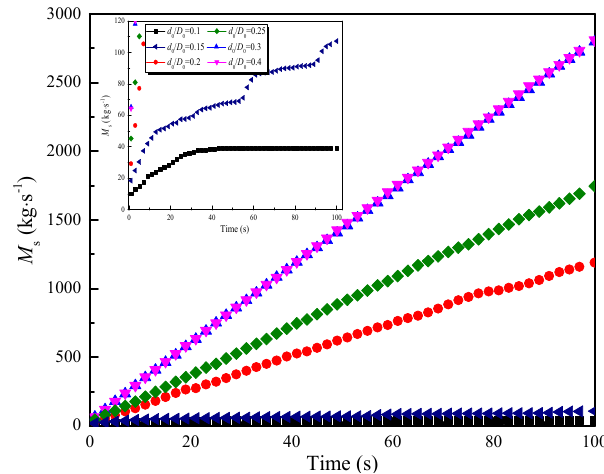
Figure 14. The variation in cumulative mass discharge with operating interval time for different normalized outlet scales and inset: the variation in cumulative mass export with the normalized outlet of 0.1 and